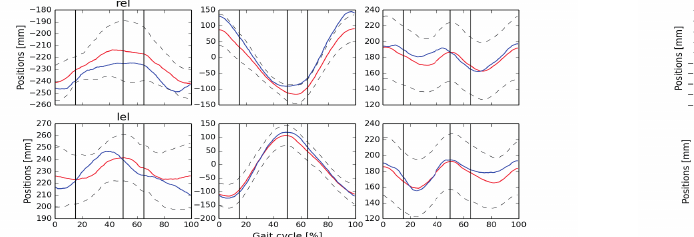
Figure 12: Comparison of knee positions